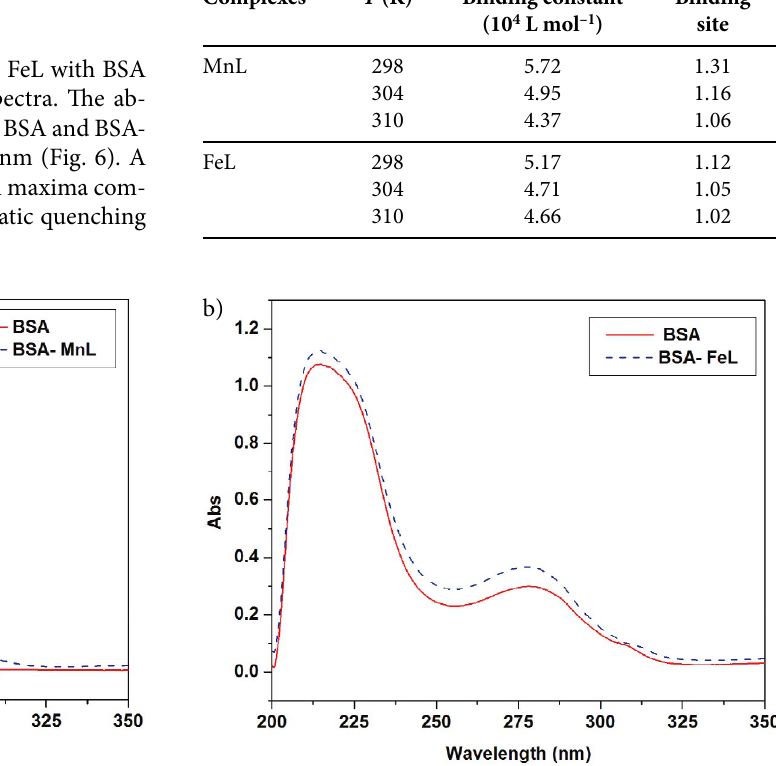
Table 2 : Binding constant ( K b ) and Binding site ( n ) values of MnL and FeL complexes Complexes T (K) Binding constant Binding (10 4 L mol –1 )